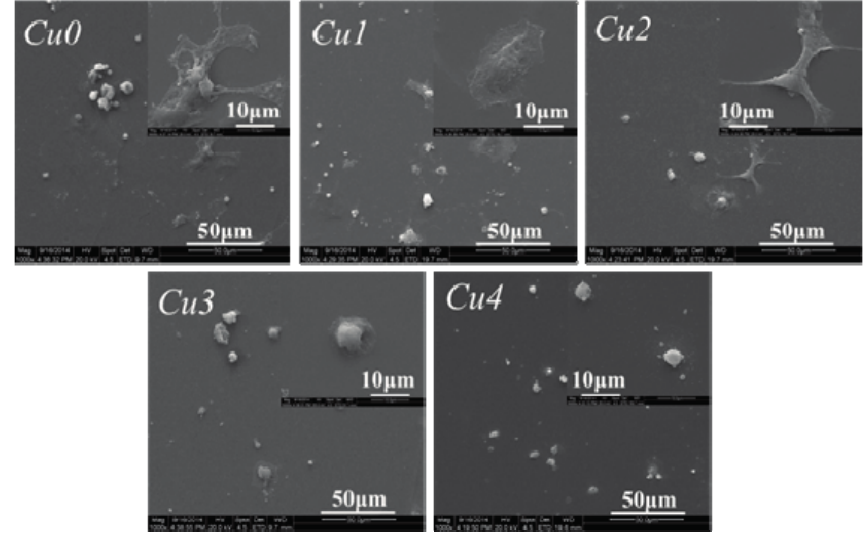
Figure 10. The SEM characterization of macrophages on the Cu0, Cu1, Cu2, Cu3 and Cu4 surfaces after 24 h of incubation.